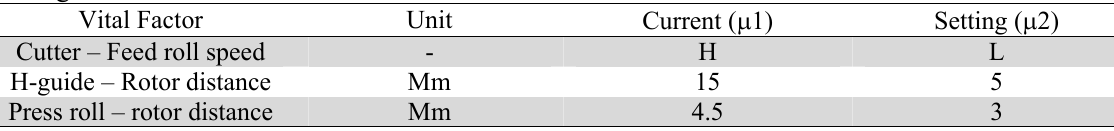
Testing of Vital Factors in the Cutter Area Vital Factor Unit Current (  ) Setting (  ) Cutter – Feed roll speed - H L H-guide – Rotor distance Mm 15 5 Press roll – rotor distance Mm 4.5 3